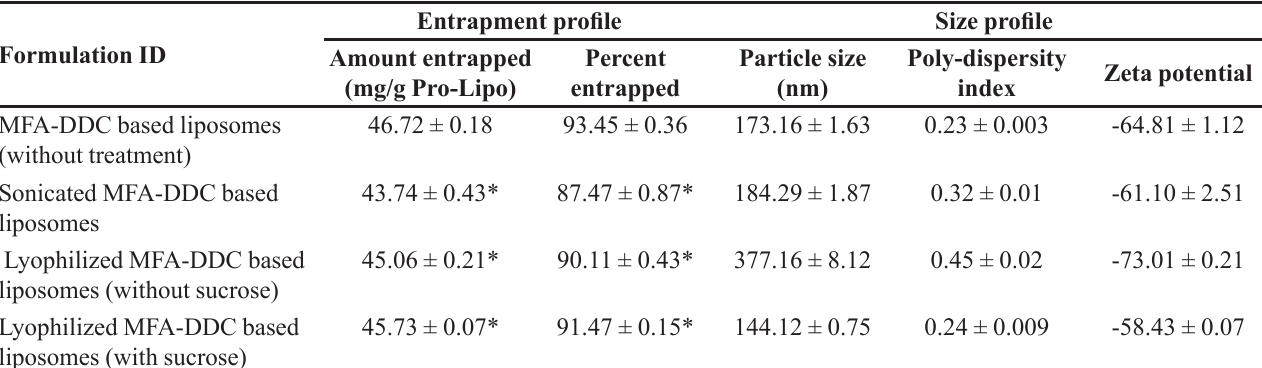
TABLE I – Drug entrapment and particle size profile before and after size reduction treatments